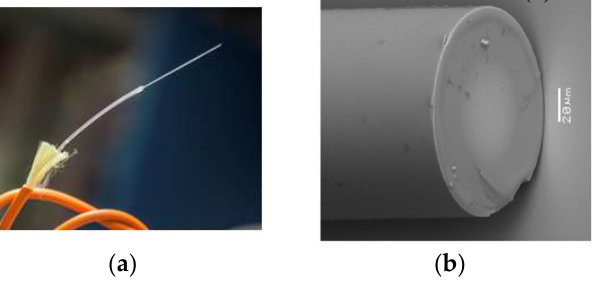
Figure 1. ( a ) Optical fiber; ( b ) SEM micrograph of the chemical sensing zone of an FOS with reflection geometry (xerogel membrane at the tip). Taken from Echeverria et al. (2016).